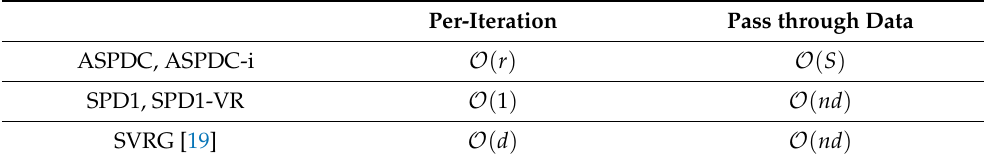
Table 2. Complexity comparison of per-iteration and pass through